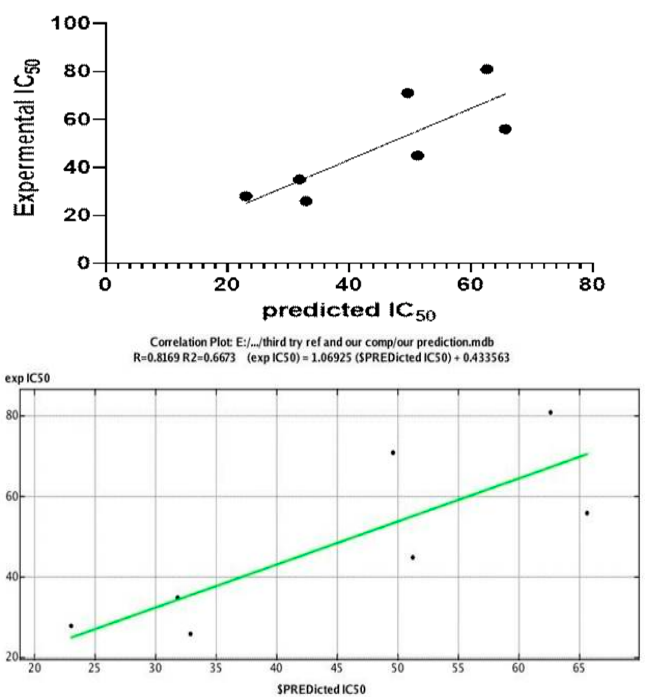
Figure 5. The correlation plot between predicted IC50 ($Pred.) values on the x -axis and IC50 values on the y -axis for compounds 2 , 10 , 3 , 12b , 12d , 12e , and ascorbic acid. The plots give R 2 values equal to 0.6673.